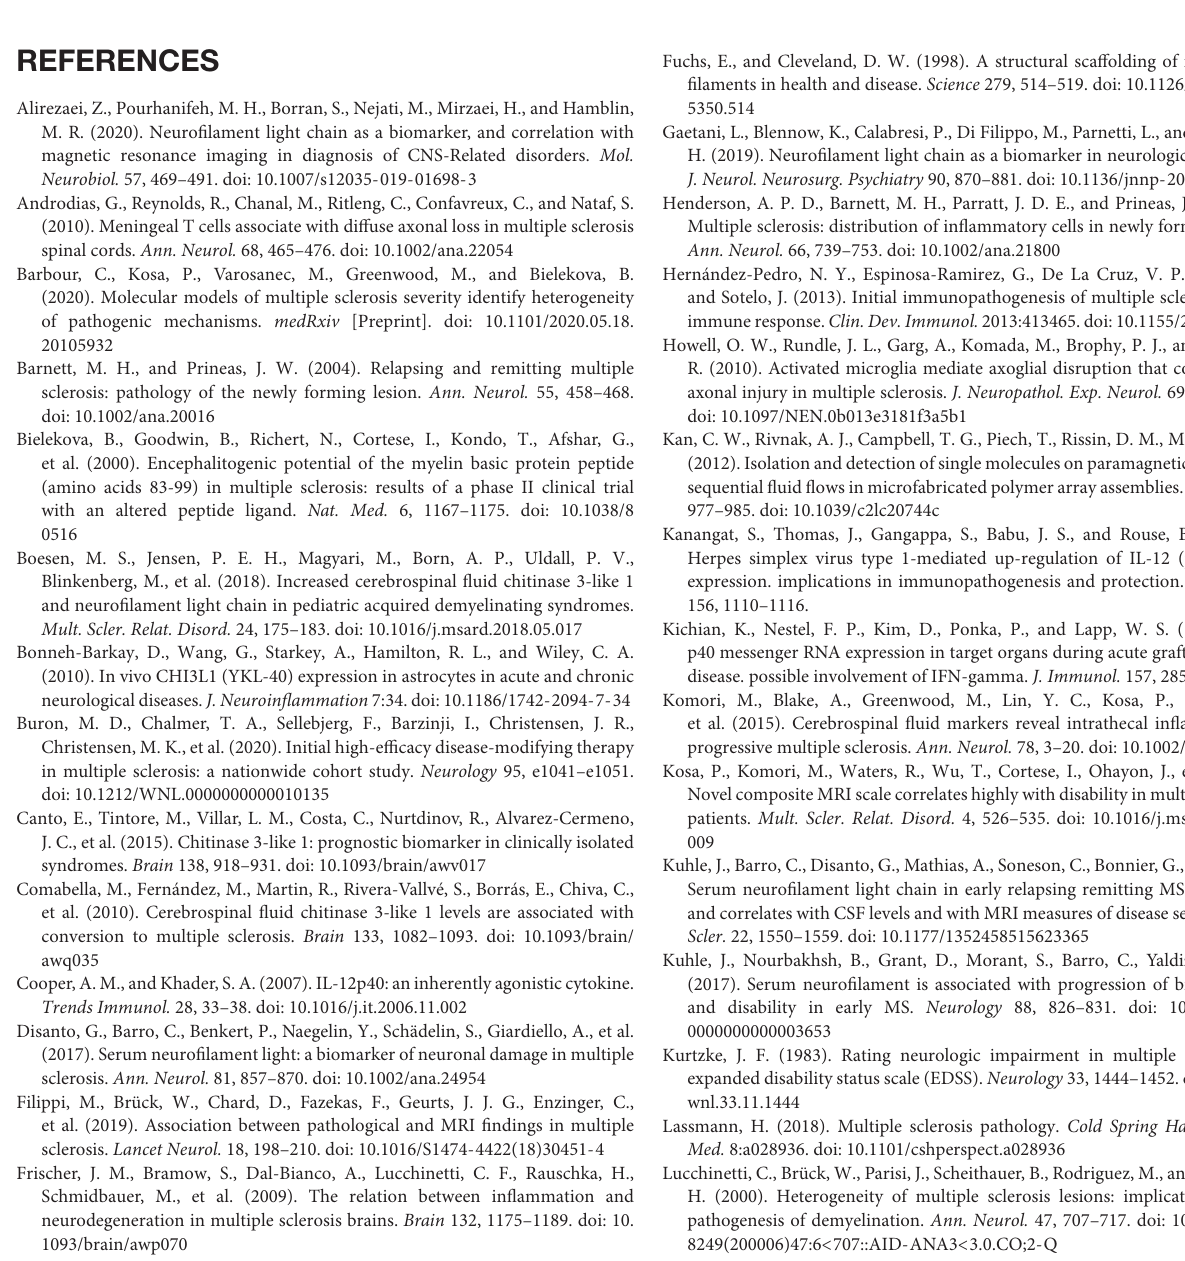
Supplementary Table 2 | In the training cohort, within MS patients ( n = 70) correlations between number of CELs and all analyzed biomarkers were analyzed using Spearman analysis; Only statistically significant correlations ( p < 0.01) are